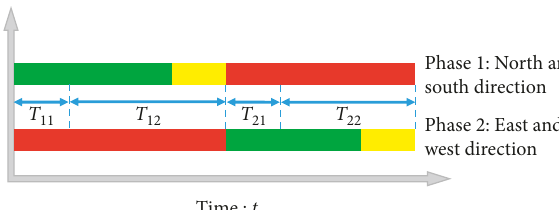
Figure 4: Diagram of phase decomposition of the signalized in- tersection (green, yellow, and red indicate the duration of the green, yellow, and red lights